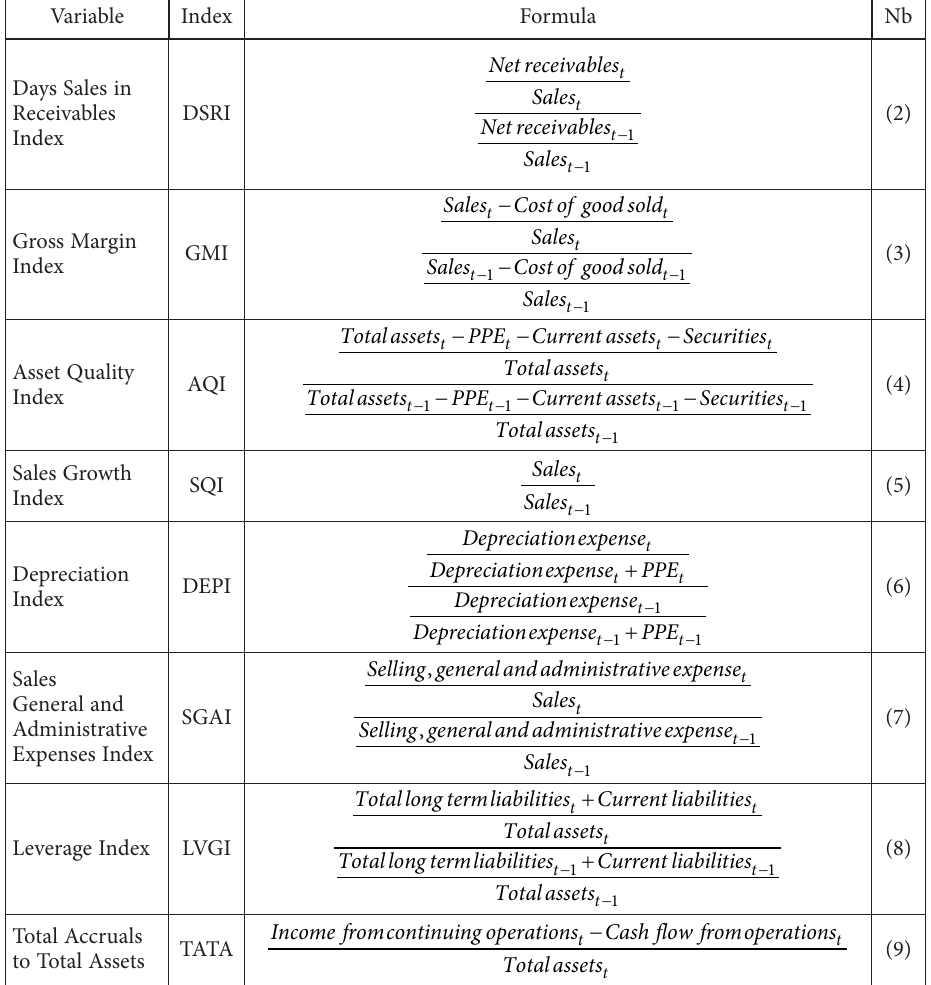
Table 1. Beneish model variables –